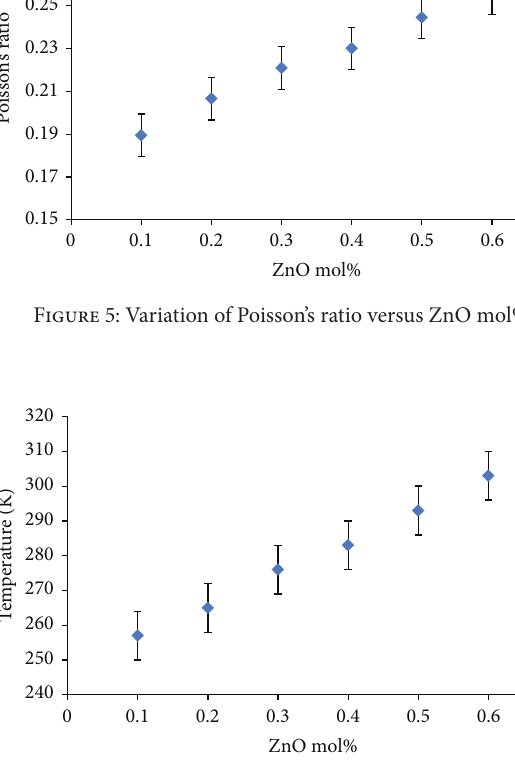
Figure 4: Variation of elastic moduli versus ZnO mol%.